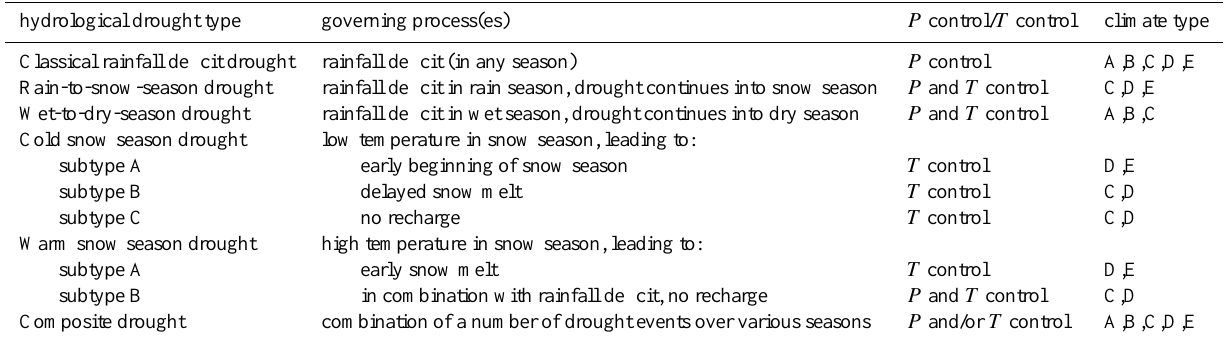
Table 3. Drought propagation processes per hydrological drought type and occurrence in K¨oppen-Geiger major climate types (also visualised in Fig. 1; Van Loon and Van Lanen,